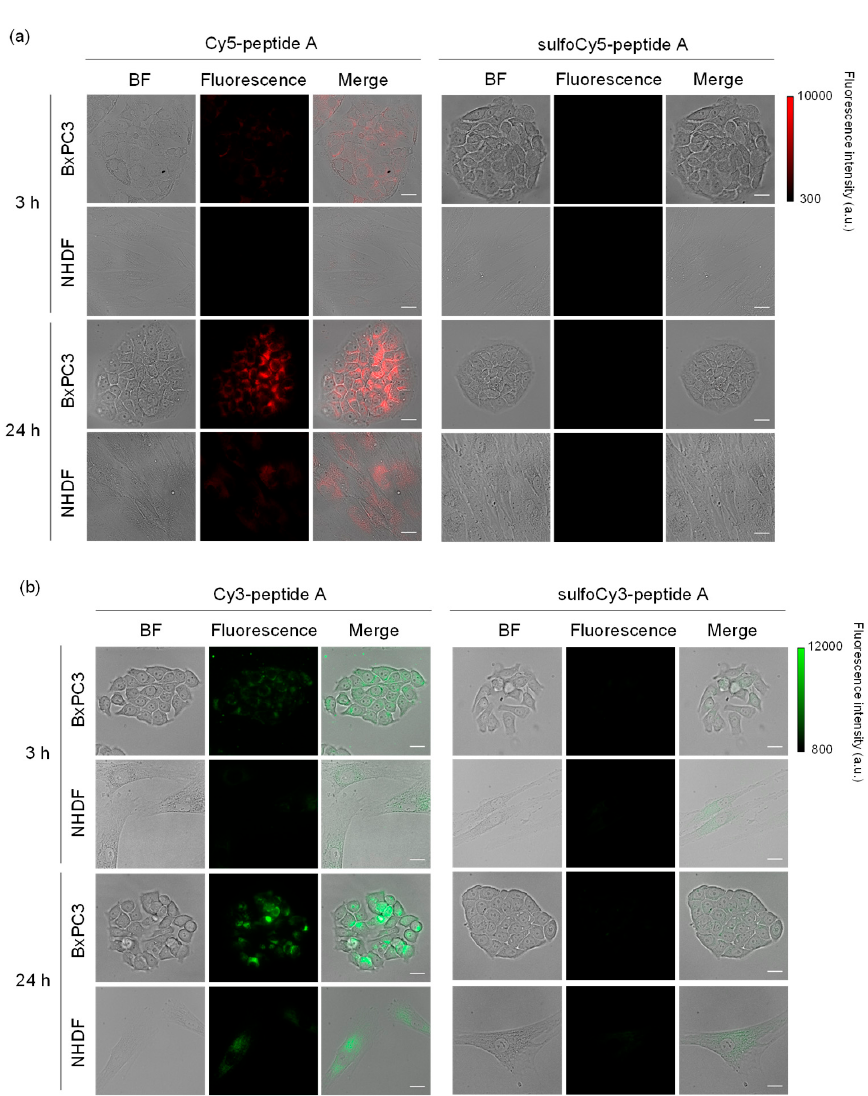
Figure 2. Fluorescence images of BxPC3 and NHDF cells treated with dye-peptide A. ( a ) Cy5/sulfoCy5-peptide A, ( b ) Cy3/sulfoCy3-peptide A. Cells were incubated with 0.1 µ M dye- peptide A at 37 ◦ C for 3 or 24 h before imaging. Bright field (BF), Cy5/Cy3 fluorescence, and merge images are shown. Scale bar: 10 µ